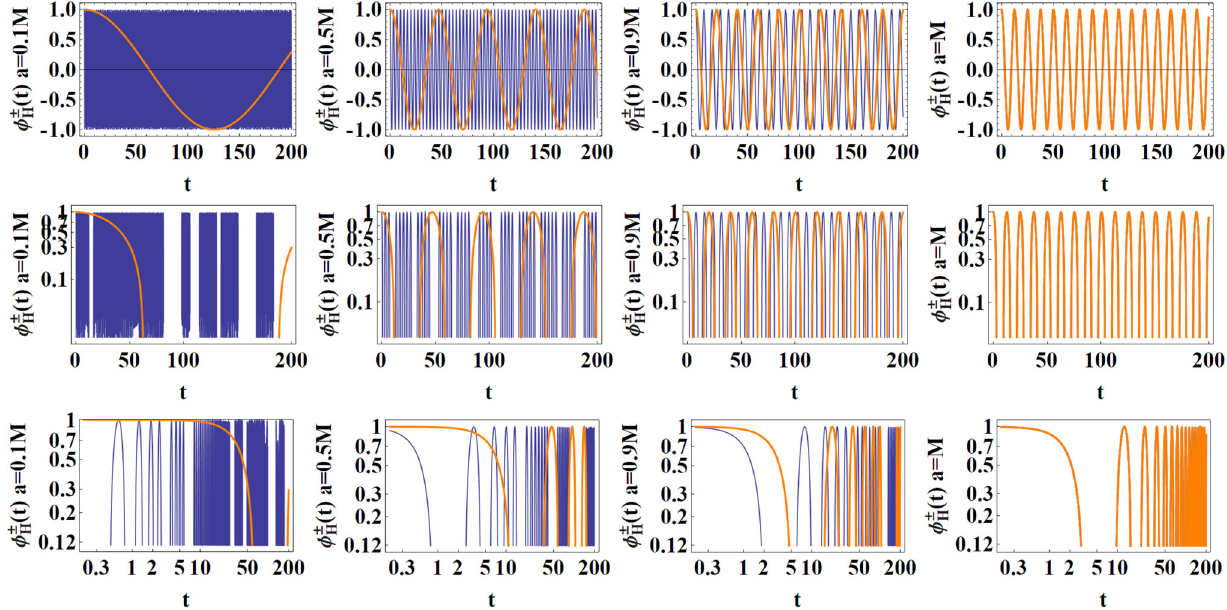
(ω ± ) associated with metric bundles H H ω + < ω − are the frequencies of the outer H H = ω − for a = M . Plots H H